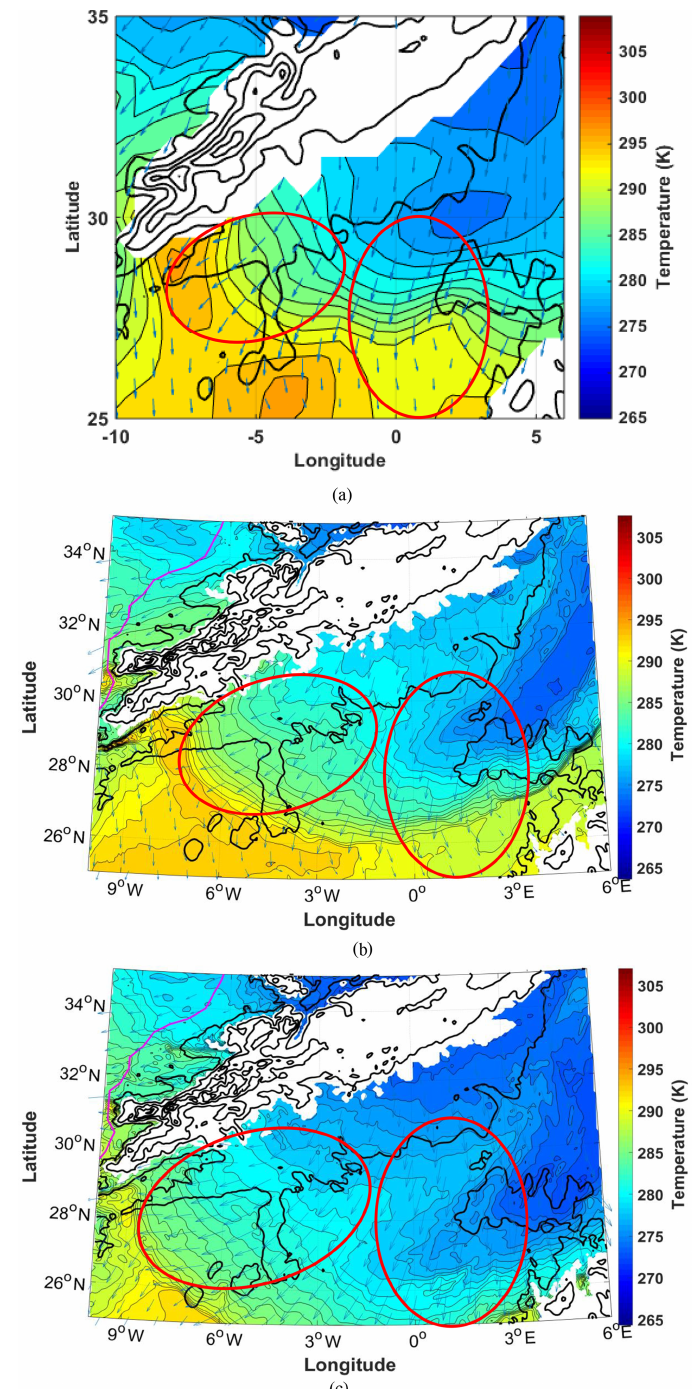
Figure 6. (a) Temperature and wind speed and direction at 925hPa on 18:00UTC 2 March 2004 (54km resolution MERRA product) (Pokharel, 2016). Blue arrow lines indicate the wind flow. The red circled areas represent the turning of one wind component to the right in response to the Coriolis force and another component turning to the left away from the mountains farther north and east as it goes south- southwestward. (b) Temperature and wind speed and direction at 925hPa on 18:00UTC 2 March 2004 (6km resolution WRF product). Blue arrow lines indicate the wind flow. The red circled areas represent the turning of one wind component to the right in response to the Coriolis force and another component turning to the left away from the mountains farther north and east as it goes south-southwestward. (c) Temperature and wind speed and direction at 925hPa on 22:00UTC 2 March 2004 (6km resolution WRF product). Blue arrow lines indicate the wind flow. The red circled areas represent the turning of one wind component to the right in response to the Coriolis force and another component turning to the left away from the mountains farther north and east as it goes south-southwestward. Earth Syst. Dynam., 10, 651–666,